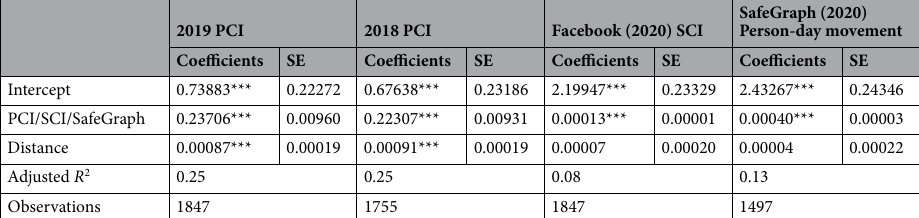
Table 3. Regression result using COVID-19 infection rate as the dependent variable, and PCI, SCI, or SafeGraph as the predictor variable controlling for distance. * p < 0.1, ** p < 0.05, *** p <